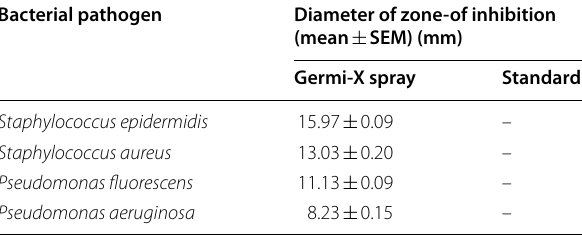
Table 1 Diameters of zones-of-inhibition formed by germicidal sprays on lawns of different bacterial pathogens Bacterial